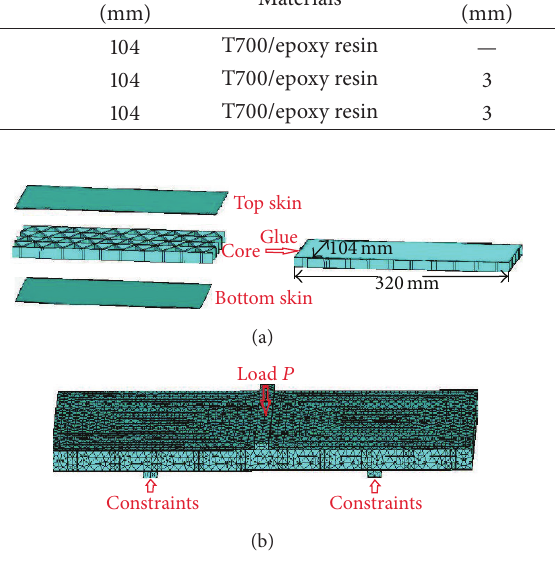
Figure 4: (a) Sandwich structure model. (b) FEM mesh